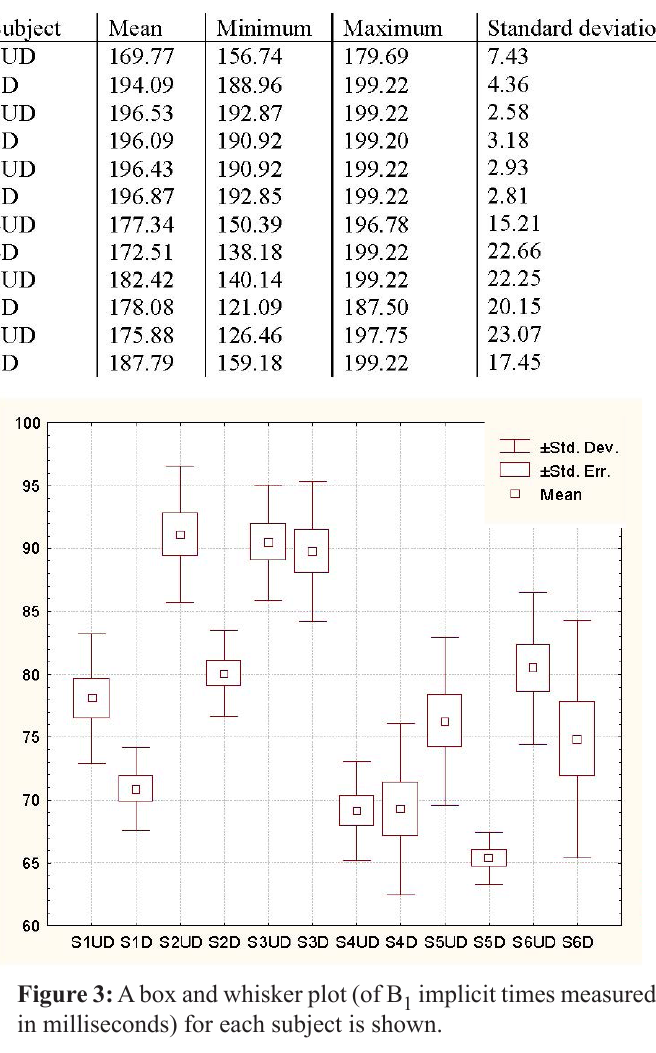
Table 4: The mean C implicit time, minimum, maximum and 1 standard deviation of ten recordings for each eye of each subject are given. Values are recorded in milliseconds.